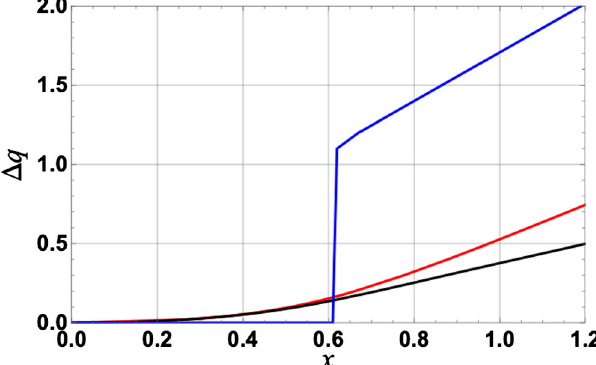
FIG. 8. Required tune spread (half width at the bottom of the assumed externally given elliptical tune distribution) normalized by the synchrotron tune Q s to reach bunch stability vs the normalised bunch intensity x in the presence of TD for the case of Fig. 4: (black line) using the one-mode approach, leading to the usual stability diagram; (red line) with the two-mode approach from Eq. (3). The blue line corresponds to the case without TD (but considering the mode coupling between modes 0 and -1).